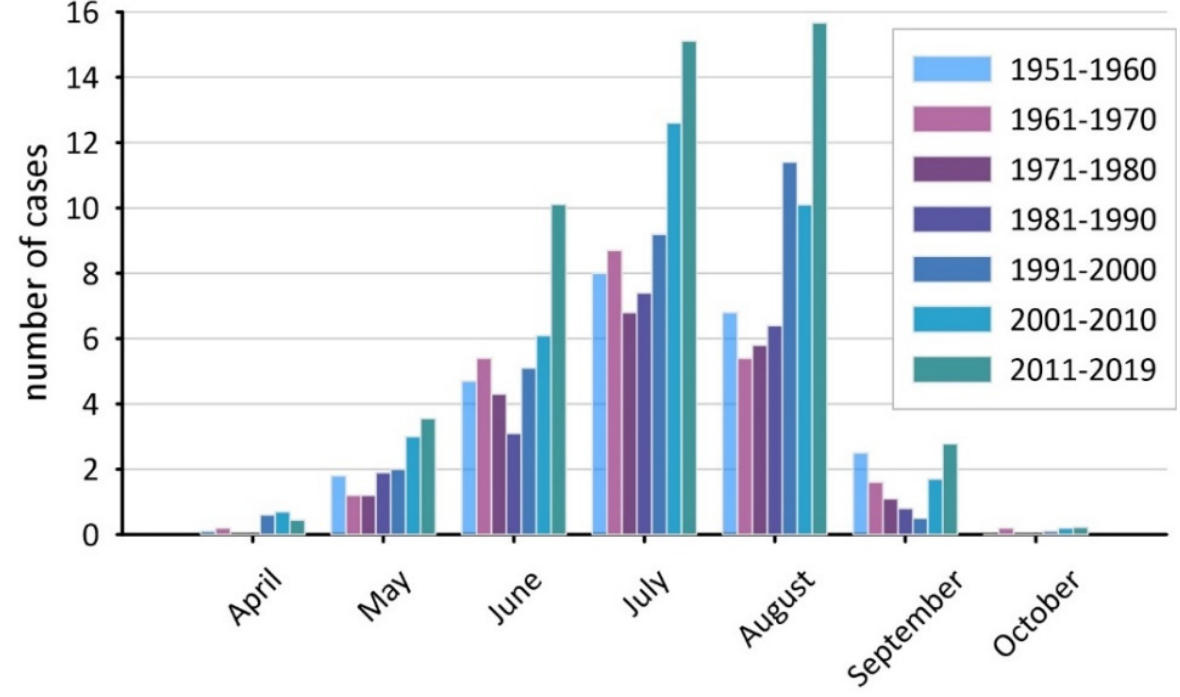
Figure 7. Average monthly numbers of hot days from April to October in the following decades. In order to trace the circulation conditions conducive to the occurrence of heat waves in Poland, the longest heat waves were selected, during which the temperature exceeded the thresholds at least at 25% of analyzed stations (in this case, 10). Their list is presented in Table 1. Only 11 waves observed simultaneously at 10 stations lasted a week or more. Only one of them occurred in the first half of the analyzed period and six of them (more than half) occurred in the last decade. The two longest waves, 16 and 13 days long, happened in the 1990s. In July 2006, two heat waves occurred; they are further referred to as 2006a and 2006b. Four colder days separated them. Table 1. The longest heat waves observed simultaneously at least at 10 stations in Poland. Length of Wave in